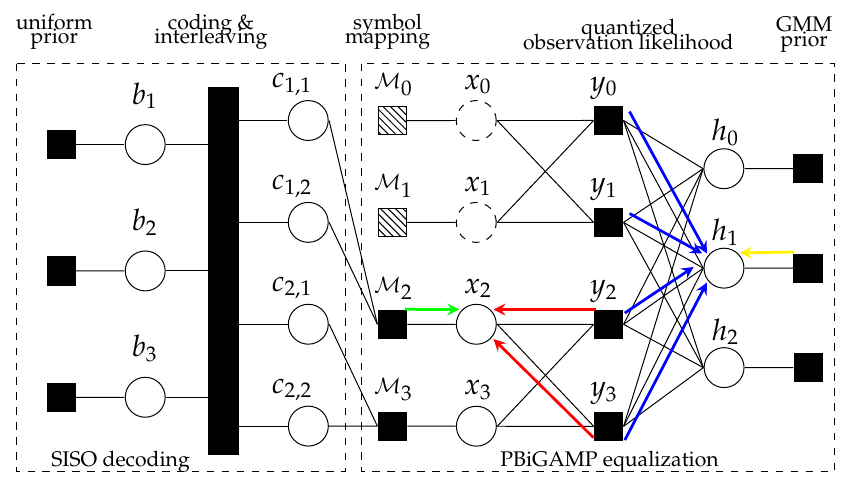
Figure 2. The factor graph corresponding to the single-carrier